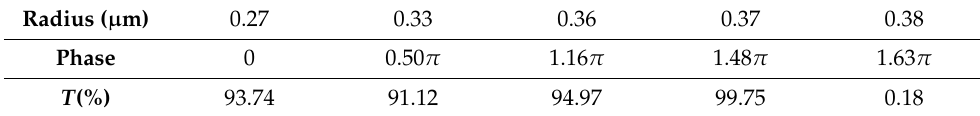
direction (transmissive end) in the Y–Z plane, respectively. Table 1. The transmittance and additional phase for the various radii. Radius ( µ Table 1. The transmi tt ance and additional phase for the various radii.